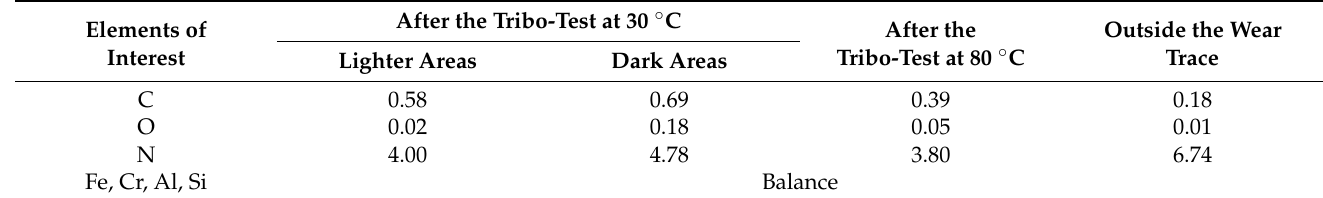
Table 3. Atomic [%] composition of the wear traces on the plate.